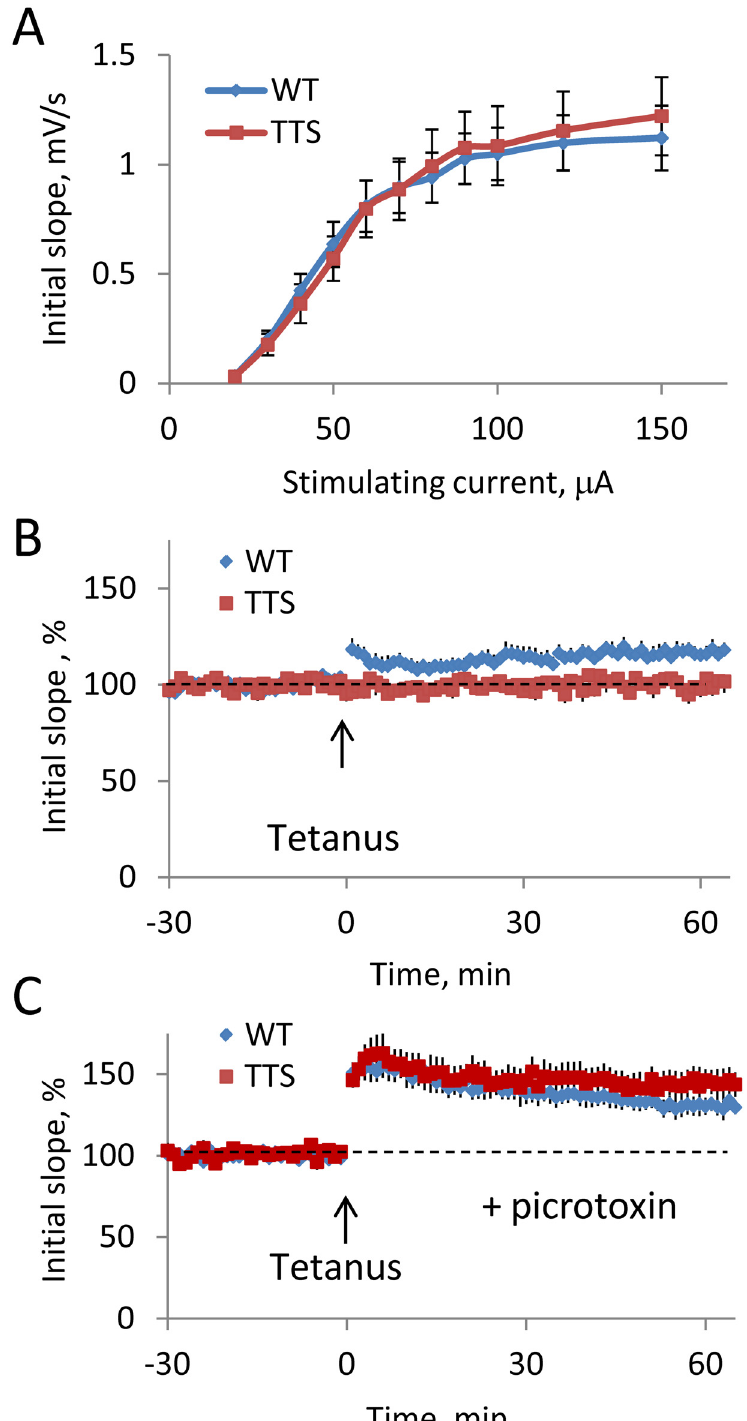
Fig 6. Synaptic efficiency and plasticity in the dentate gyrus. A: Input-output relationship in the DG. Evoked responses were similar in MML of WT and TTS DG (blue and red markers respectively). B: Time course of the averaged initial slope of field EPSPs during the experiment. Tetanization (arrow) evoked stable LTP in WT, but not in TTS mice (blue and red markers respectively). The results are mean ± SEM. The number of slices/mice examined: WT = 9/4; TTS = 8/4. C: Suppression of inhibition by picrotoxin allowed for